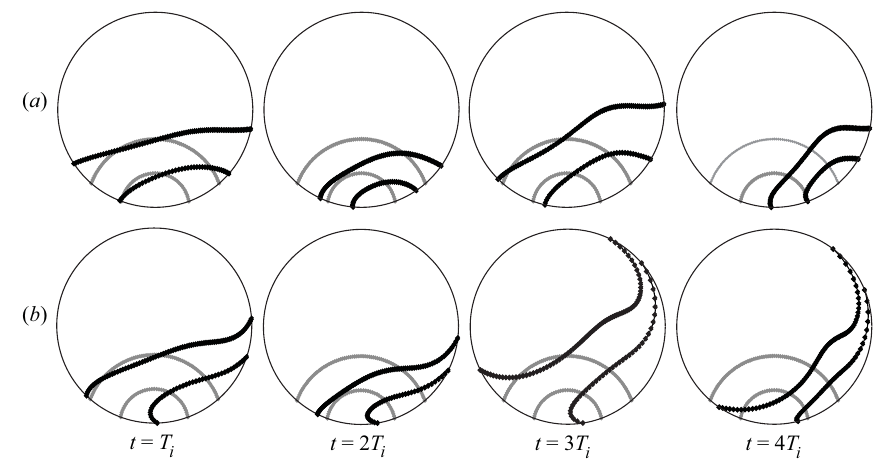
Fig. 5. Comparison of cloud patch evolutions obtained in the field containing only the first vertical mode (row- a ) and in the field including the second vertical mode (row- b ). Grayed points represent the initial position of particles. ( B = 2, h 2 = 1, h 3 = 2, W = 1).